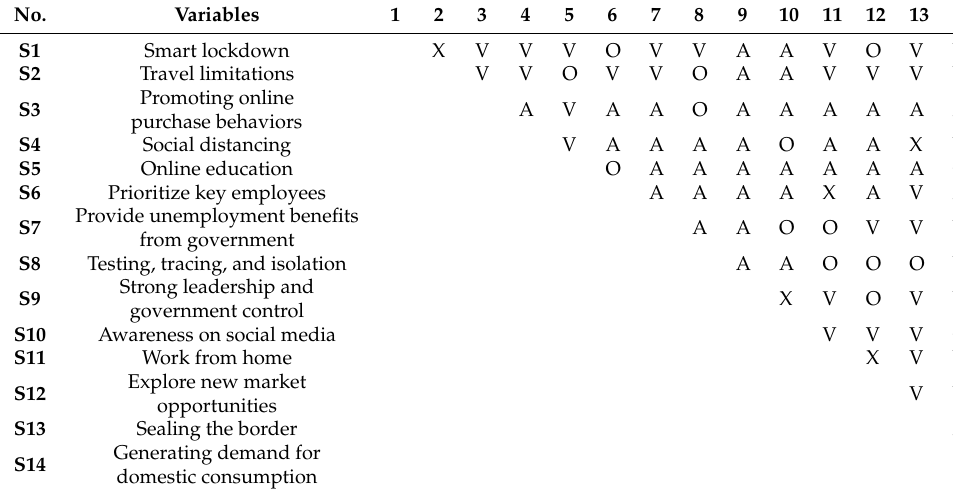
Table 2. Structural Self-interaction Matrix (SSIM) .